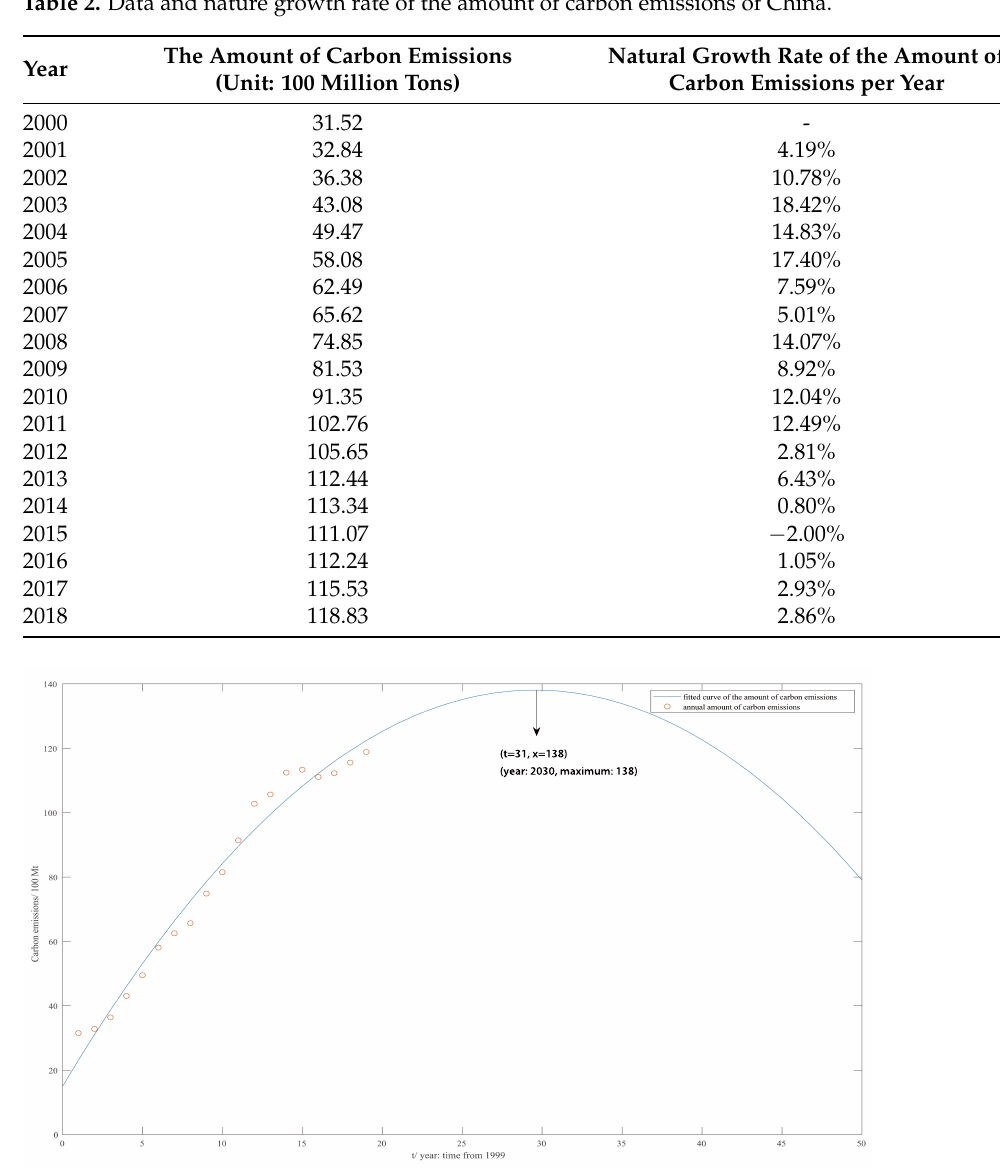
Table 2. Data and nature growth rate of the amount of carbon emissions of China.